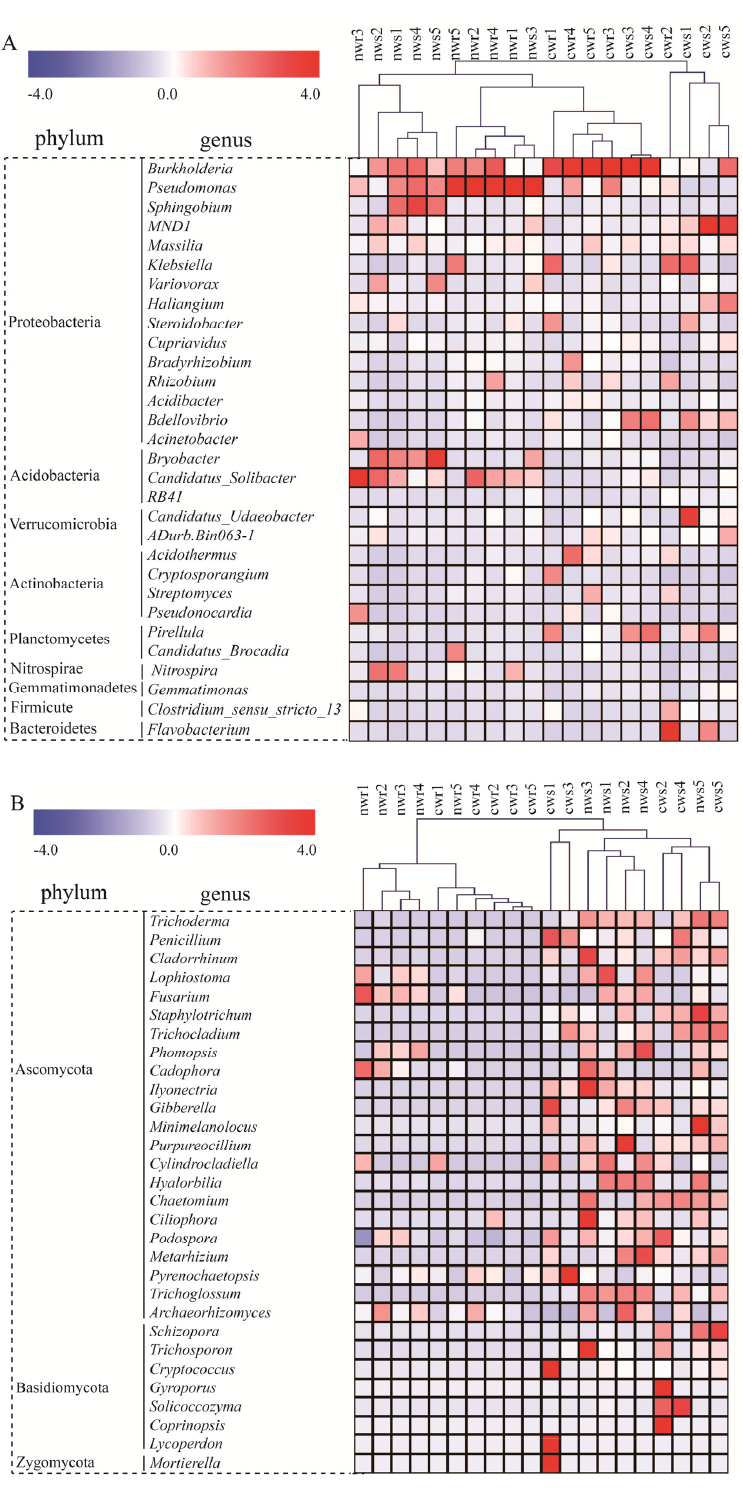
Figure 6. The 30 most abundant ( A ) bacterial and ( B ) fungal taxa in the rhizosphere and root endosphere across all sampling locations. Heatmap representing the hierarchical clustering of naturally grown and cultivated trees samples as well as relative changes in the abundance of bacterial and fungal genera inhabiting the rhizosphere and root endosphere of walnut. The red color indicates higher relative abundance, whereas the blue color indicates the lower the